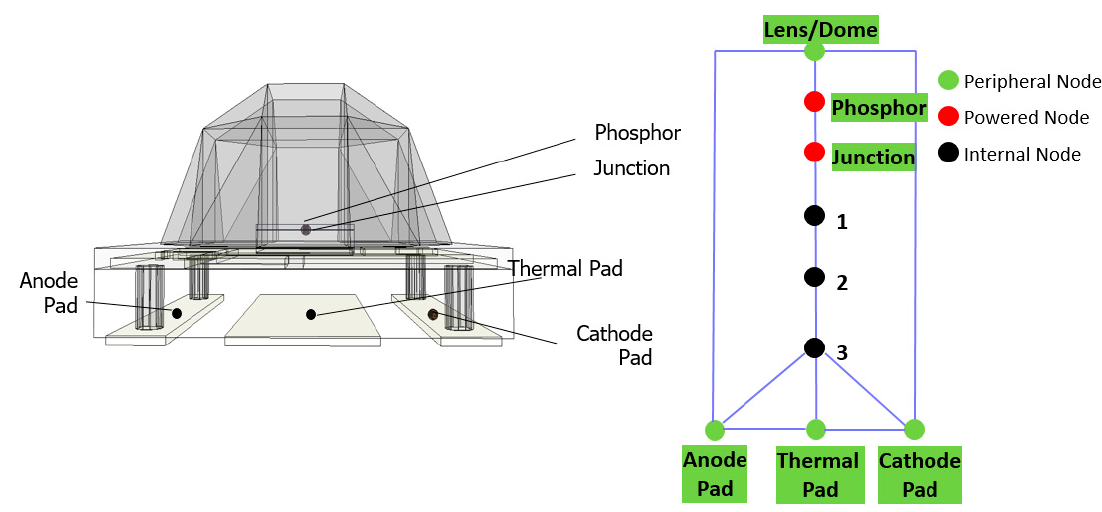
Figure 2. Delphi4LED-proposed compact thermal model (CTM) network topology (thermal resistances between all nodes, thermal capacitances at each node).